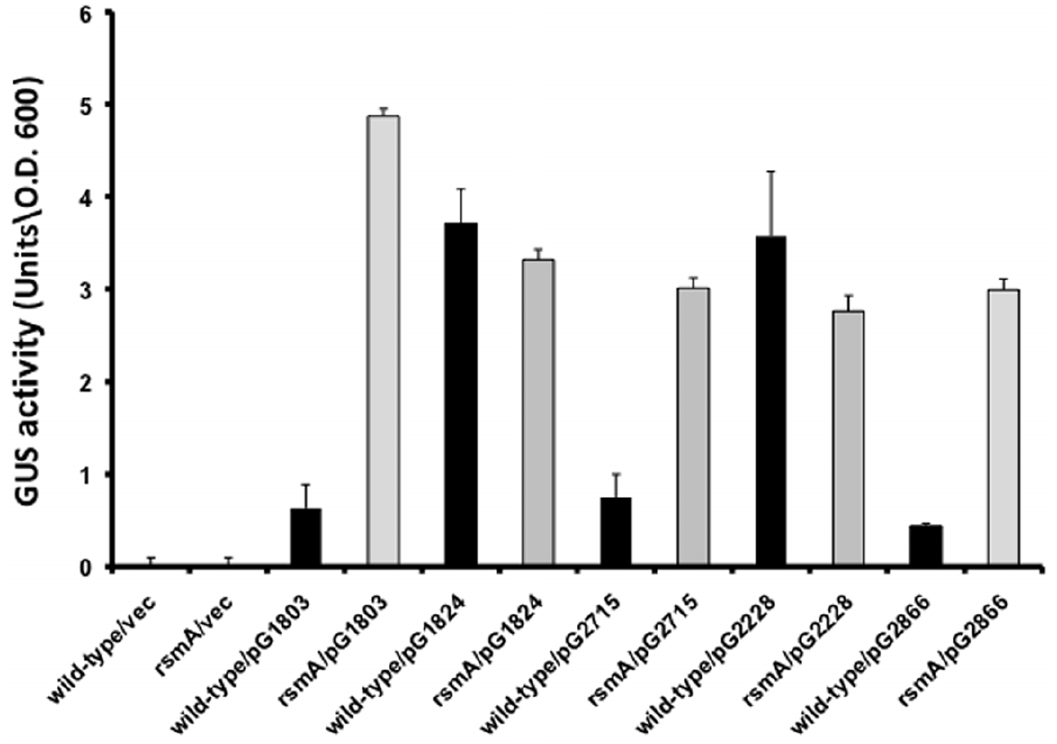
Figure 4. RsmA regulates the expression of the XC_1803, XC_2715 and XC_2866 proteins. Cells of the wild-type and rsmA mutant carrying different reporter plasmids were grown in complex media to an OD at 600nm of 1.0 and assayed for b -glucuronidase (GUS) activity as described in the Methods . Values given are means 6 standard deviations of at least five independent experiments. Vec indicates the empty vector (control) plasmid. Similar effects were seen when the bacteria were harvested at an OD at 600 nm of 0.6 or 1.5 (data not